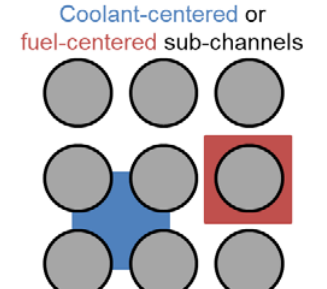
Figure 1. Schematic representation of a coolant-centered (blue, used in this paper) and a fuel rod-centered (red) CTF